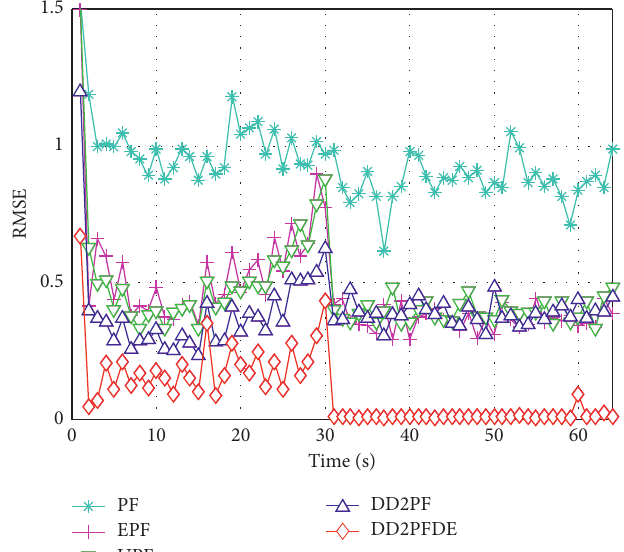
Figure 4: RMSE of SIR-PF, EPF, UPF, DD2PF, and DD2PFDE for 200 Monte Carlo simulations, where particle numbers N � 10.